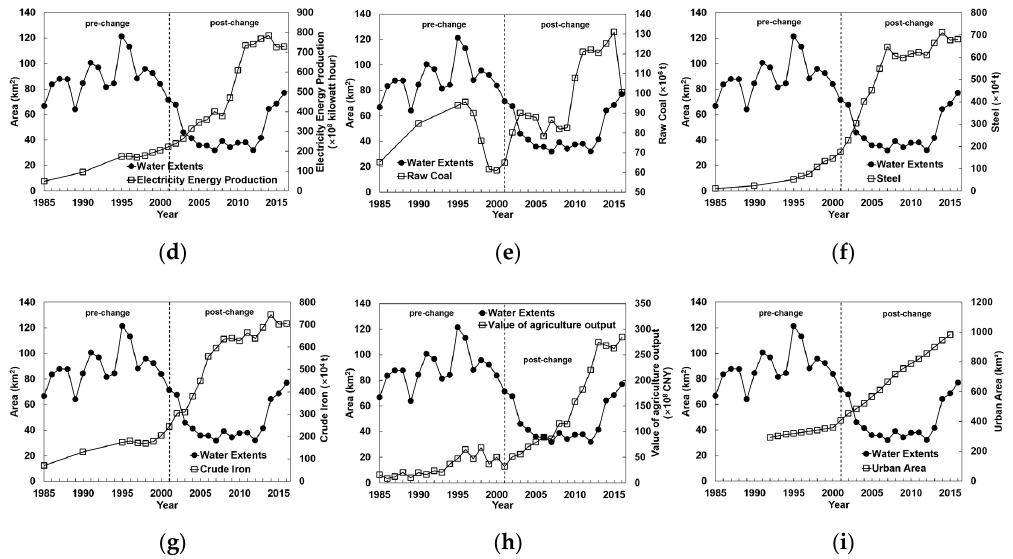
Figure 8. Temporal trends of ( a ) precipitation, ( b ) GDP, ( c ) population, ( d ) electricity energy production, ( e ) raw coal production, ( f ) steel production, ( g ) crude iron production, ( h ) value of agriculture output and ( i ) urban area, compared to reservoir water extents in the Guanting reservoir.